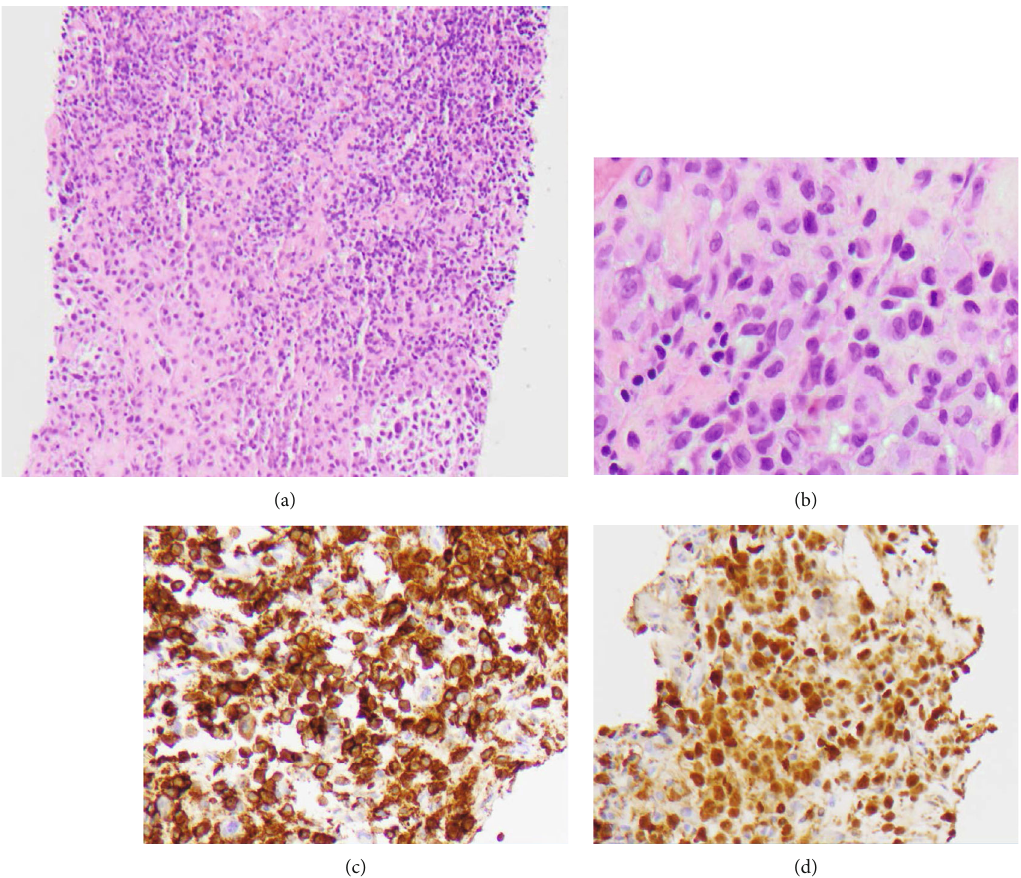
Figure 1: Hematoxylin and eosin (H&E) and immunohistochemical (IHC) staining. (a) H&E of needle core biopsy at low power showing aggregates of Langerhans cells surrounded by small mature lymphocytes. (b) H&E of LCH cells with oval nuclei showing features of nuclear grooves, occasional binucleation, and abundant cytoplasm without granules. (c) IHC for CD1a showing strong di ff use cytoplasmic staining with membranous accentuation. (d) IHC for S-100 showing variable strong to weak cytoplasmic